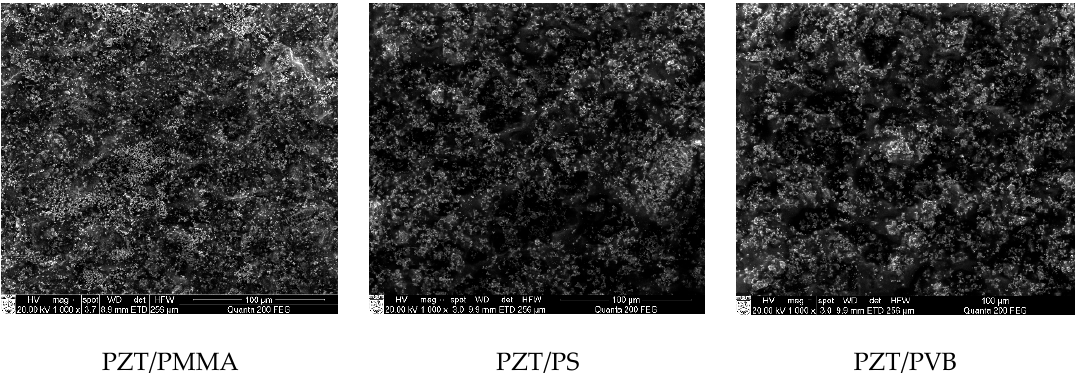
Figure 5. SEM images of the samples with different binders mixed with PZT.